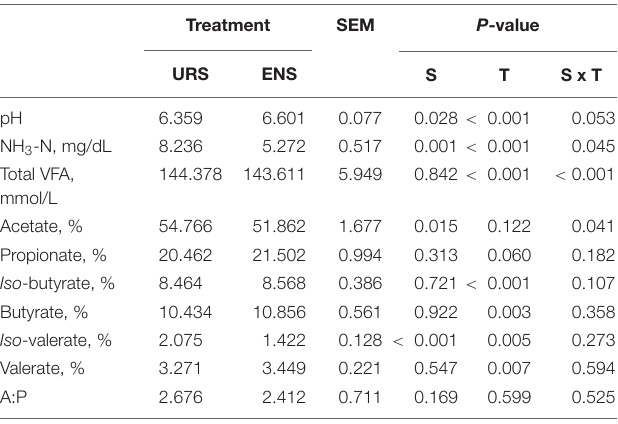
TABLE 2 | Rumen fermentation parameters in grazing Nellore Steers after 13 months of supplementation with encapsulated nitrate (ENS) or Urea